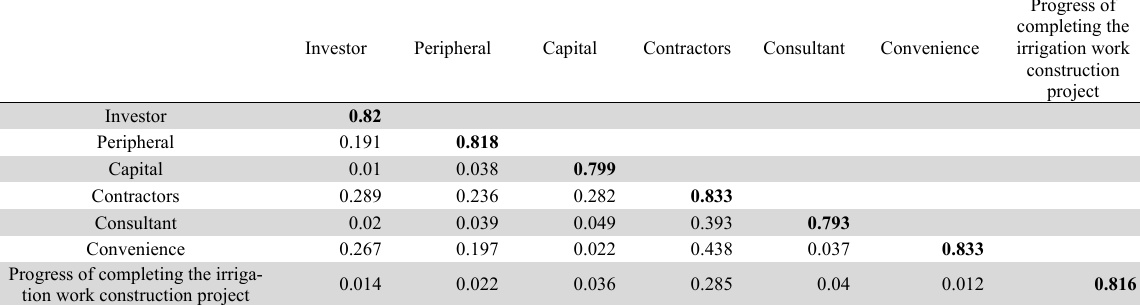
Discriminant Validity: The results of Fornell-Larcker Criterion